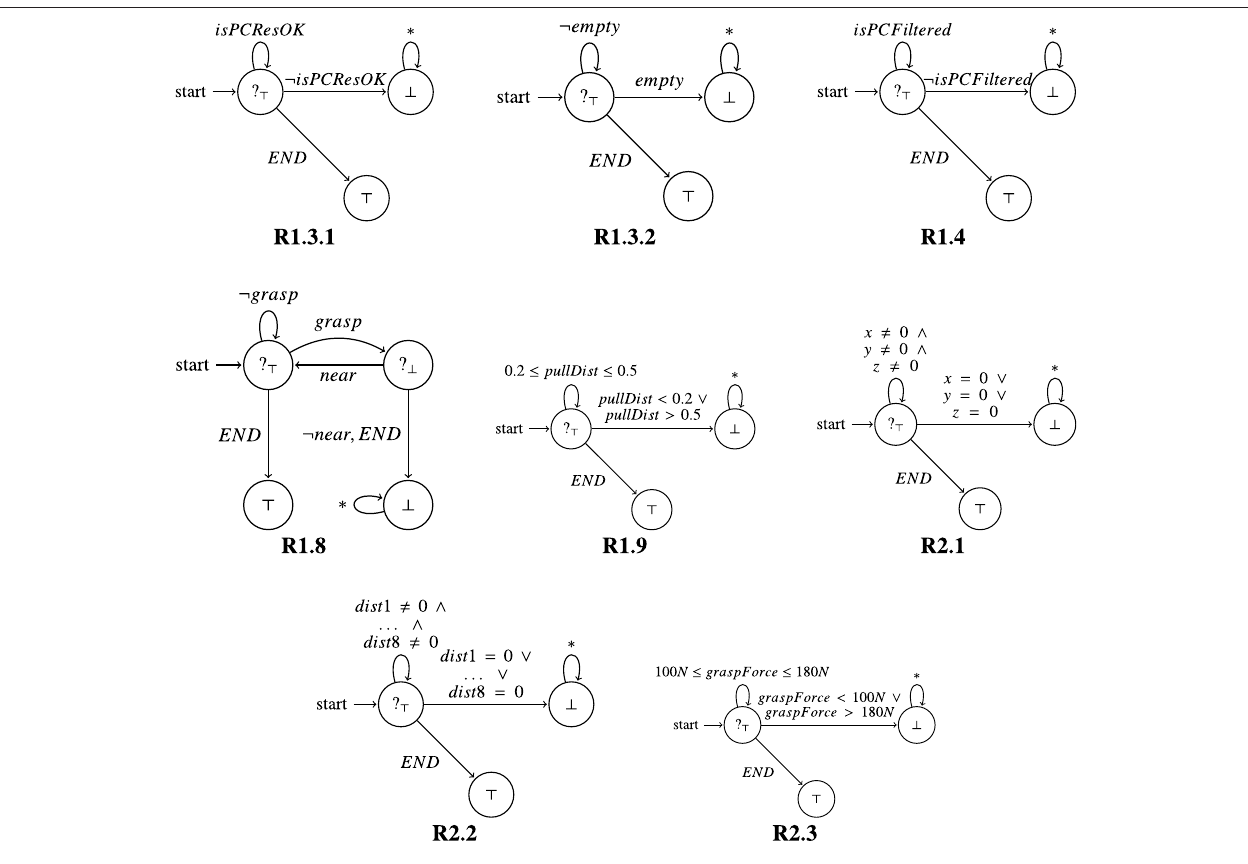
FIGURE 11 | Monitors synthesised from the requirements listed in Table 1 are represented as